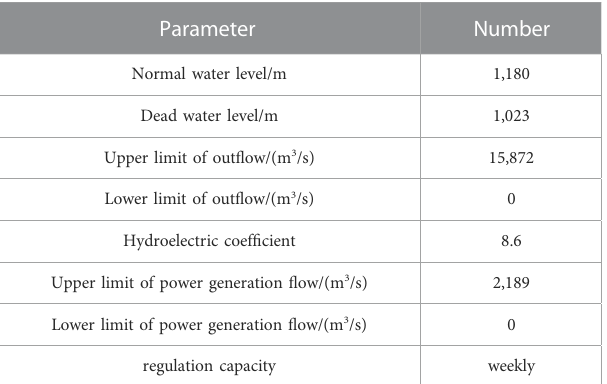
TABLE 1 Main parameters of hydropower station.